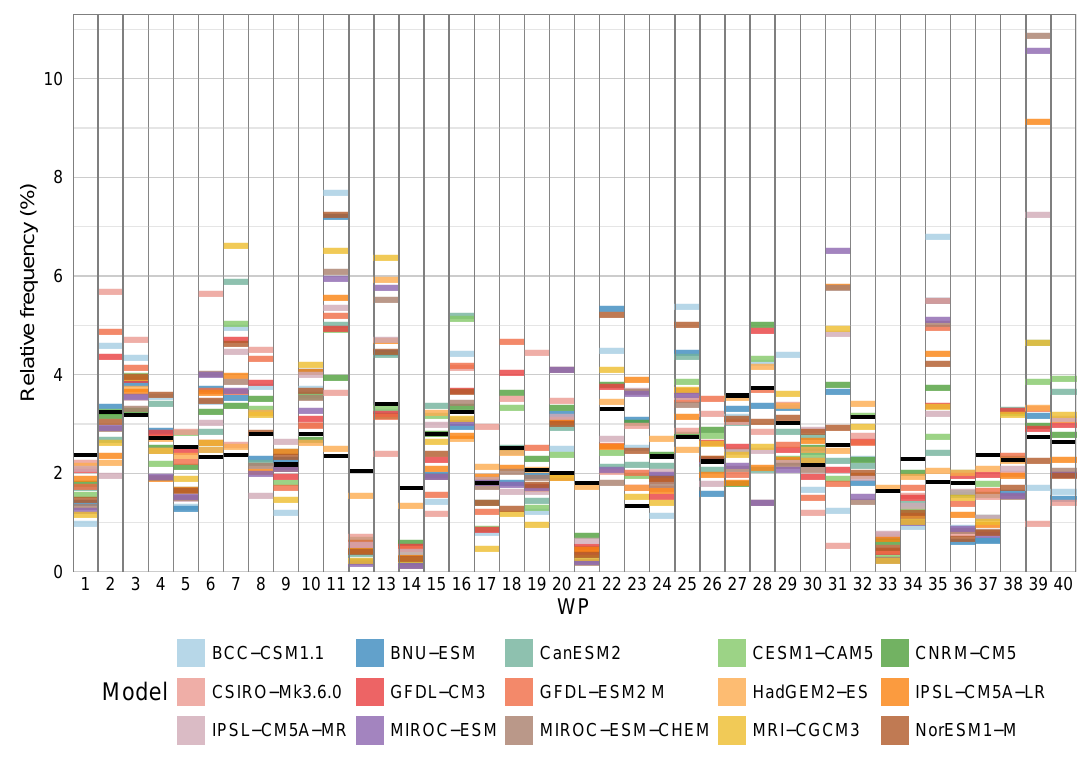
Figure 8. Relative frequency of patterns in GCMs (coloured dashes) compared to frequency in reanalysis data (black dashes).